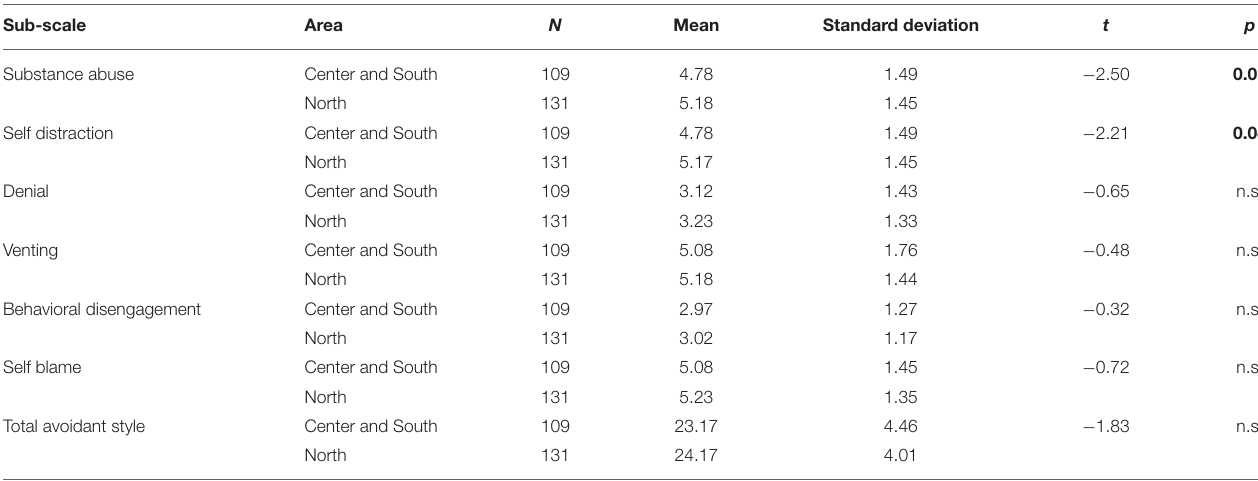
Bold values indicates the significant values.